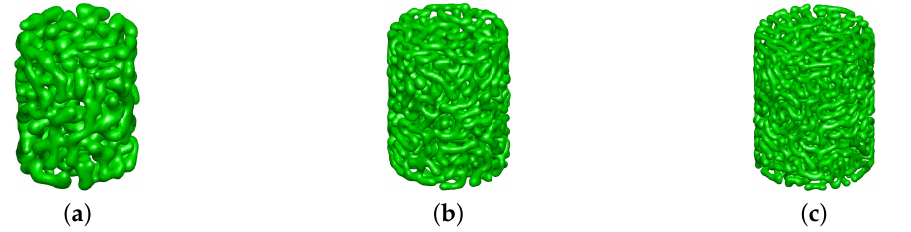
Figure 3. ( a – c ) are zero level isosurfaces of φ at t = 200 ∆ t with α = 200, 1000, and 2000, respectively, and φ ave = −